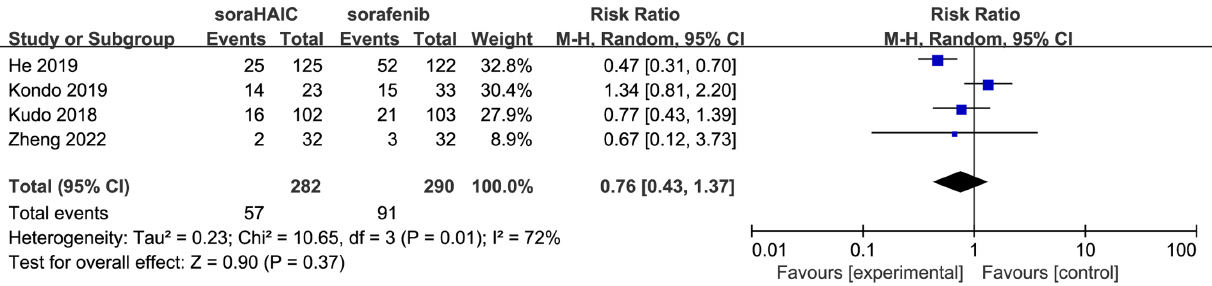
Figure 6. Forest plot comparing rate of progressive disease between the SoraHAIC and sorafenib groups. SoraHAIC, sorafenib plus hepatic arterial infusion